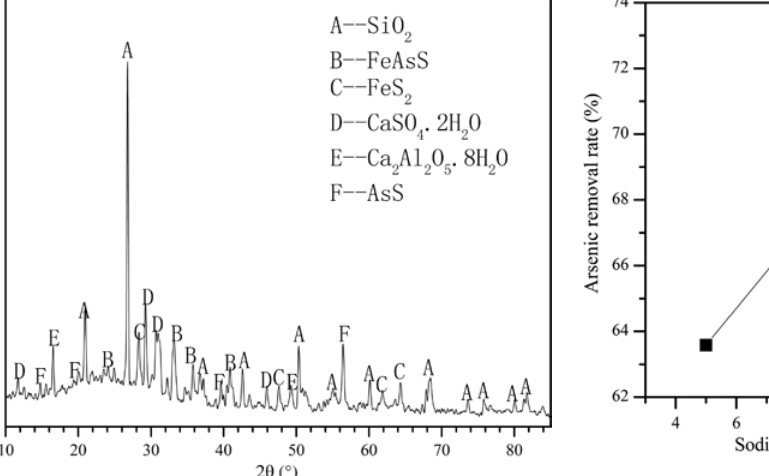
Figure 2: Effect of sodium hydroxide concentration on arsenic removal